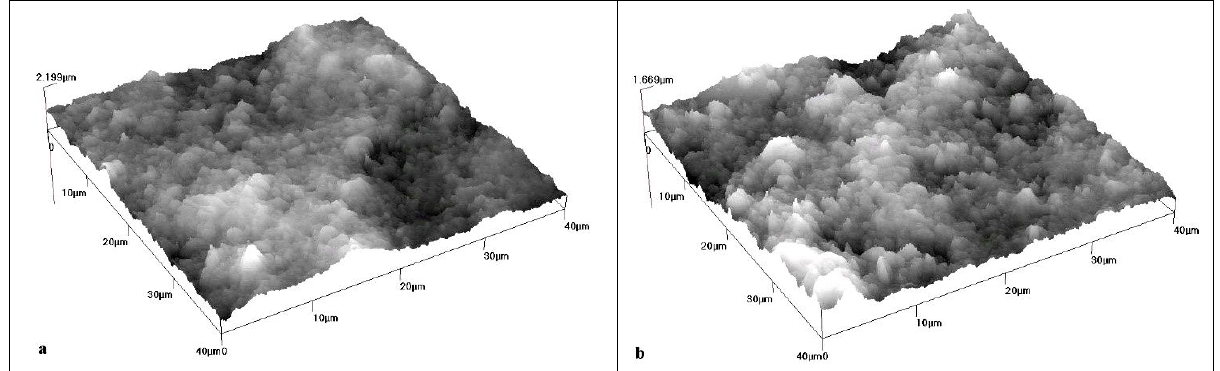
Figure 9. The AFM images: ( a ) the 3D topography of the TiN coating; ( b ) the 3D topography of the TiAlN coating. Table 5. The roughness average values of the TiN and TiAlN coatings and their measurement uncertainties.